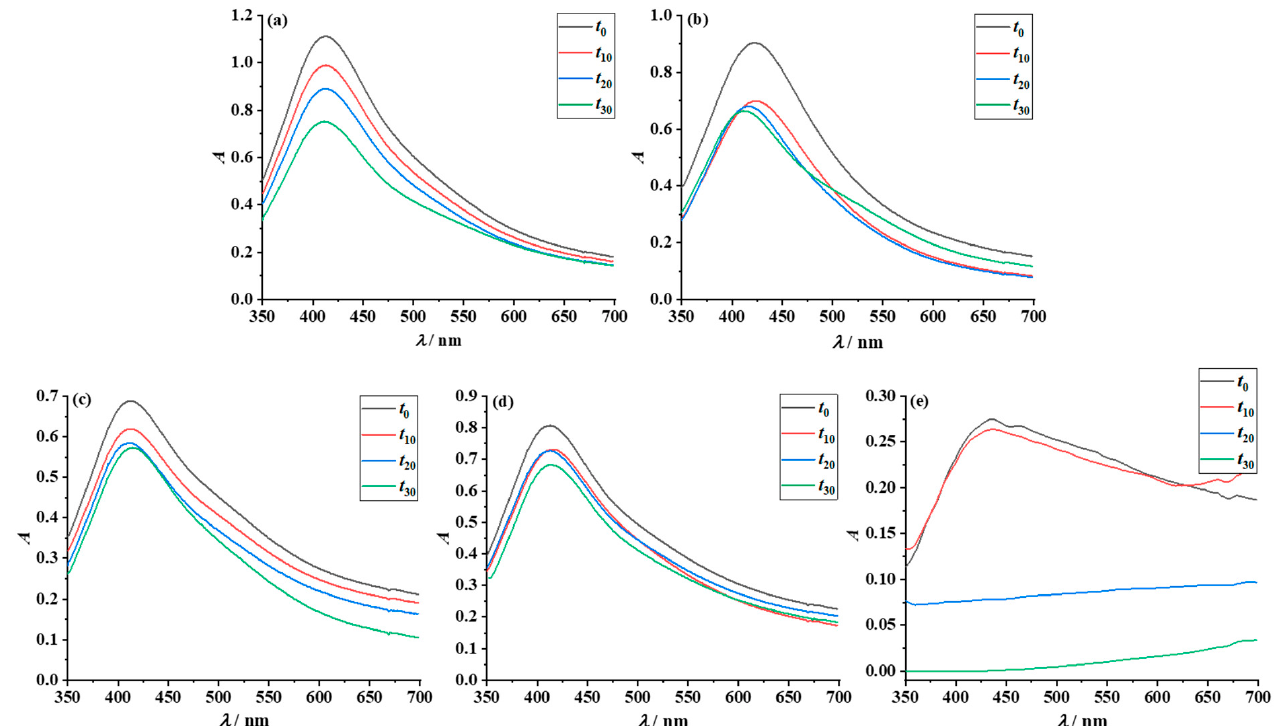
Figure 7. UV-Vis spectra recorded for MPA-PAA-AgNPs dispersed in: ( a ) water; ( b ) EG; ( c ) EtOH; ( d ) IPA; and ( e ) TpOH, over a 30 day period.